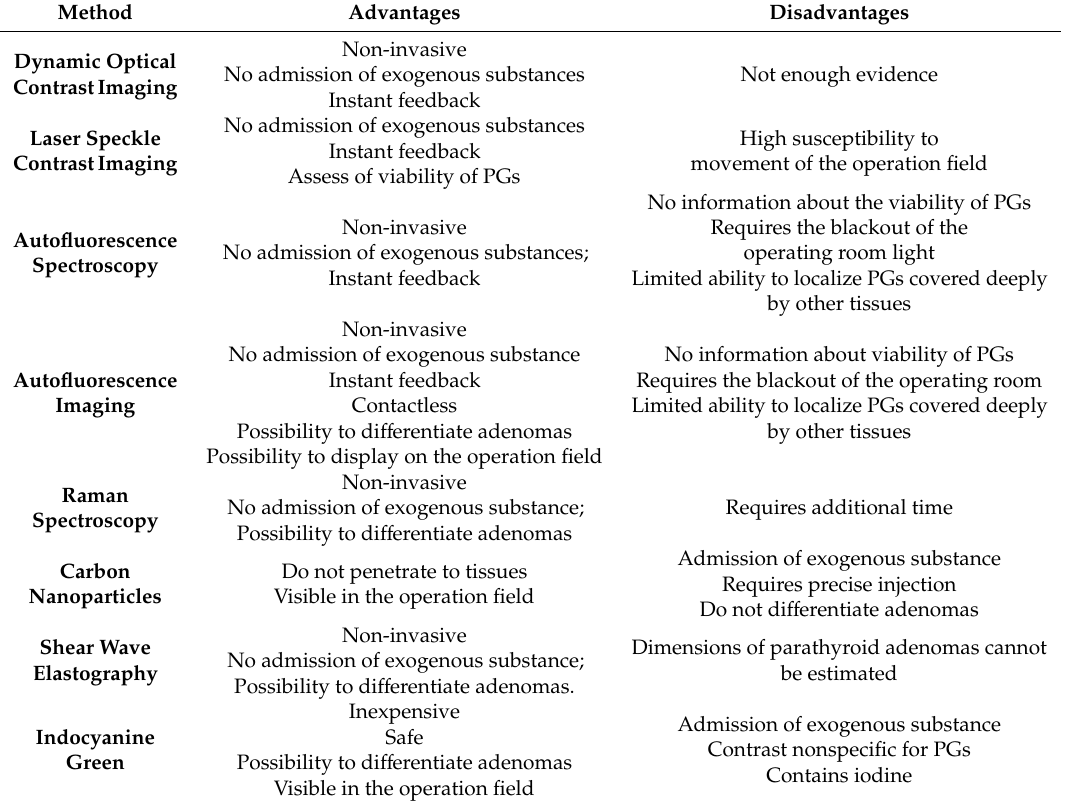
Table 2. Advantages and disadvantages of intraoperative parathyroid detection